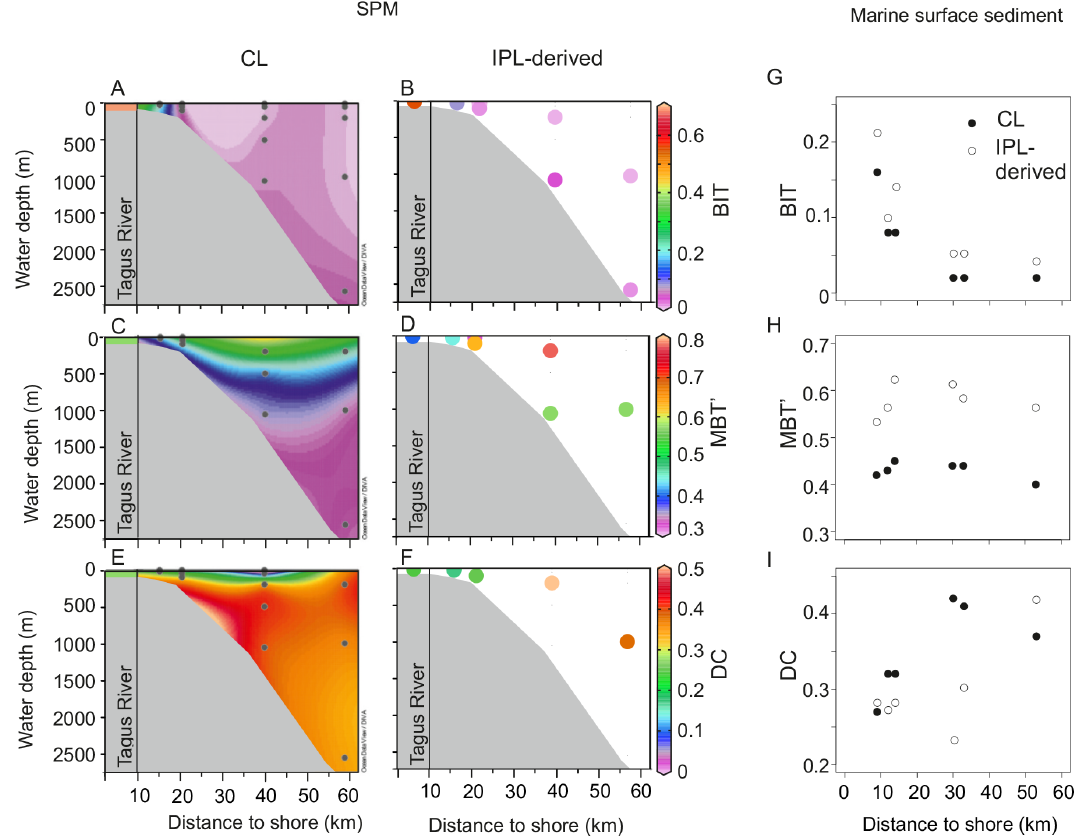
Figure 9. BIT, MBT’, and DC of CL and IPL-derived GDGTs (a–f) for marine SPM and (g–i) for marine surface sediments. The average values of the Tagus River SPM were also